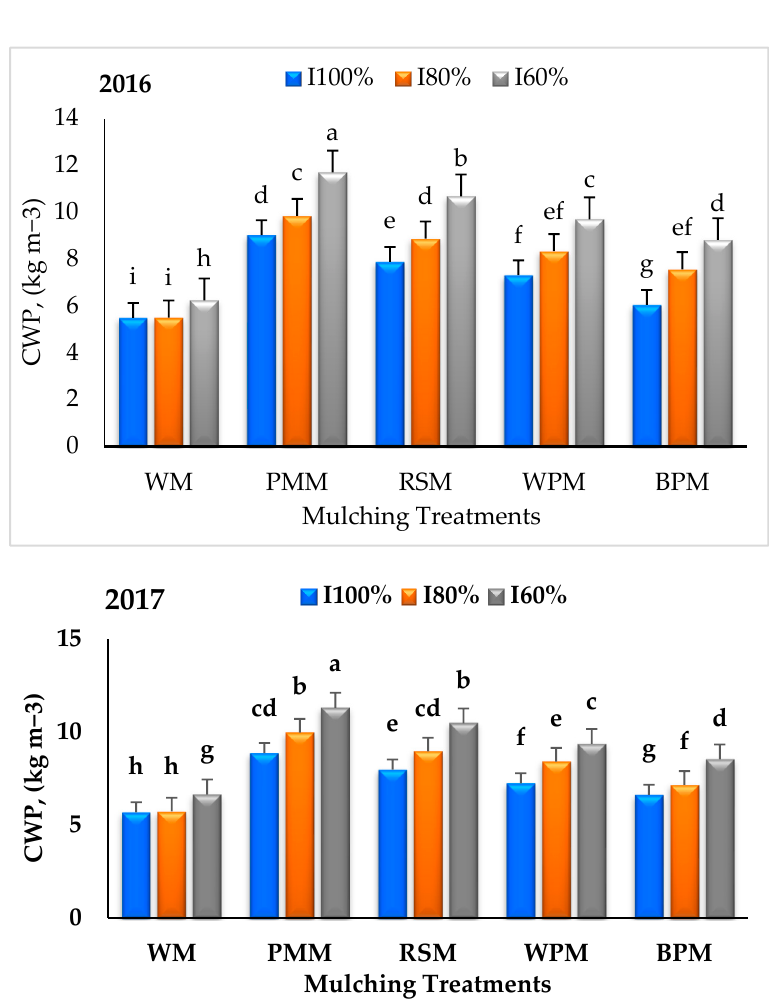
ff ect of irrigation and mulching treatments on the CWP in 2016 and 2017. Means have Figure 1. Effect of irrigation and mulching treatments on the CWP in 2016 and 2017. Figure 1. E di ff erent letters are significantly di ff erent at